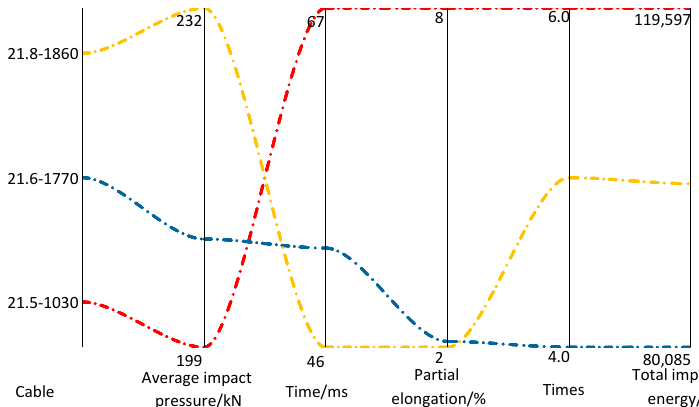
Figure 10. Comparison of dynamic characteristics of different cables.